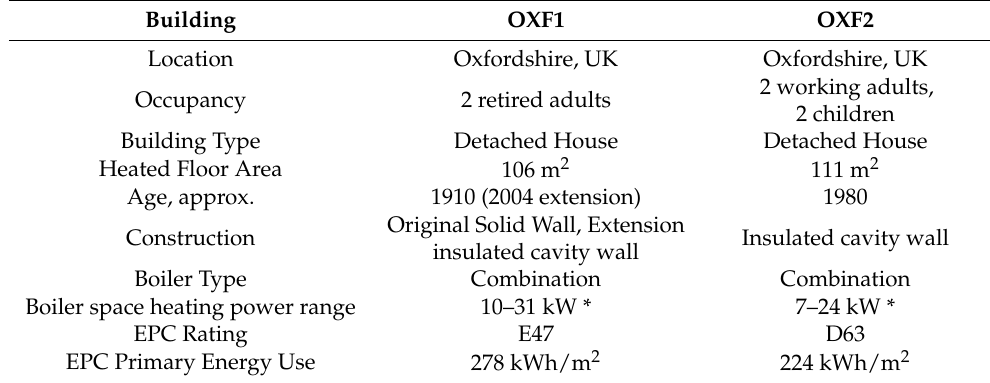
Table 1. Building